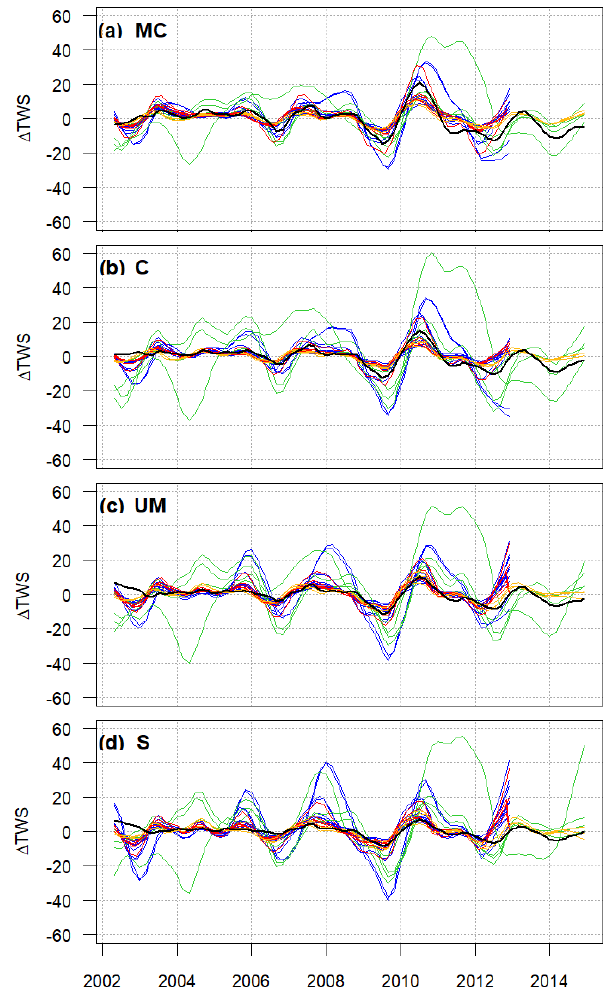
Figure 8. Long-term trends of time series for the models and GRACE for (a) MC, (b) C, (c) UM, and (d) S basins. The black lines indicate the GRACE JPL, the blue and green lines represent the GHM WRR1 and WRR2, respectively, the red lines represent the LSM WRR1, and the yellow lines show the LSM